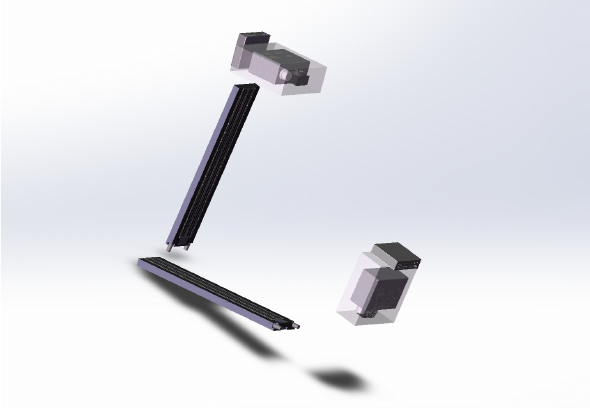
Figure 1. Two adjacent imaging modules.